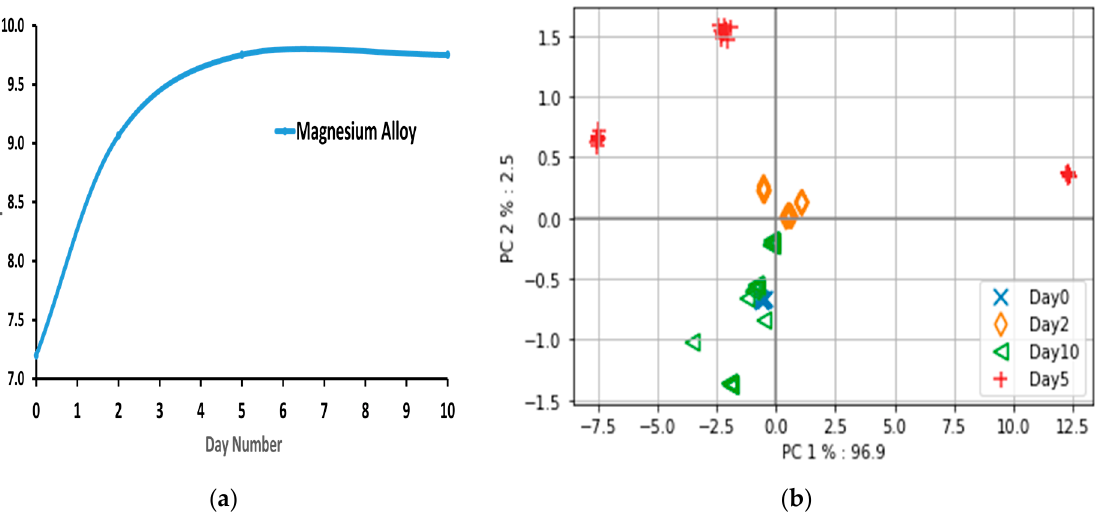
Figure 3. Observations from the in vivo experiment, including ( a ) the medium pH values over time and ( b ) the PCA-based score plot analysis of the in vitro optical data, which indicates that implant interactions with the medium result in a detectable change over days. In contrast to the trend observed in the in vitro experiment, it was not possible to differentiate the days in the in vivo experiment using PCA-based score plots. For instance, in Figure 4a, the day 3 samples exhibit two 100% separate clusters, representing the rats’ optical information on the same day. However, the reason for such different separations requires further investigation. Animals naturally exhibit biological variability that can influence the local physiological response to the implant, leading to differences in the optical spectra and the creation of distinct clusters, unlike in vitro experiments.